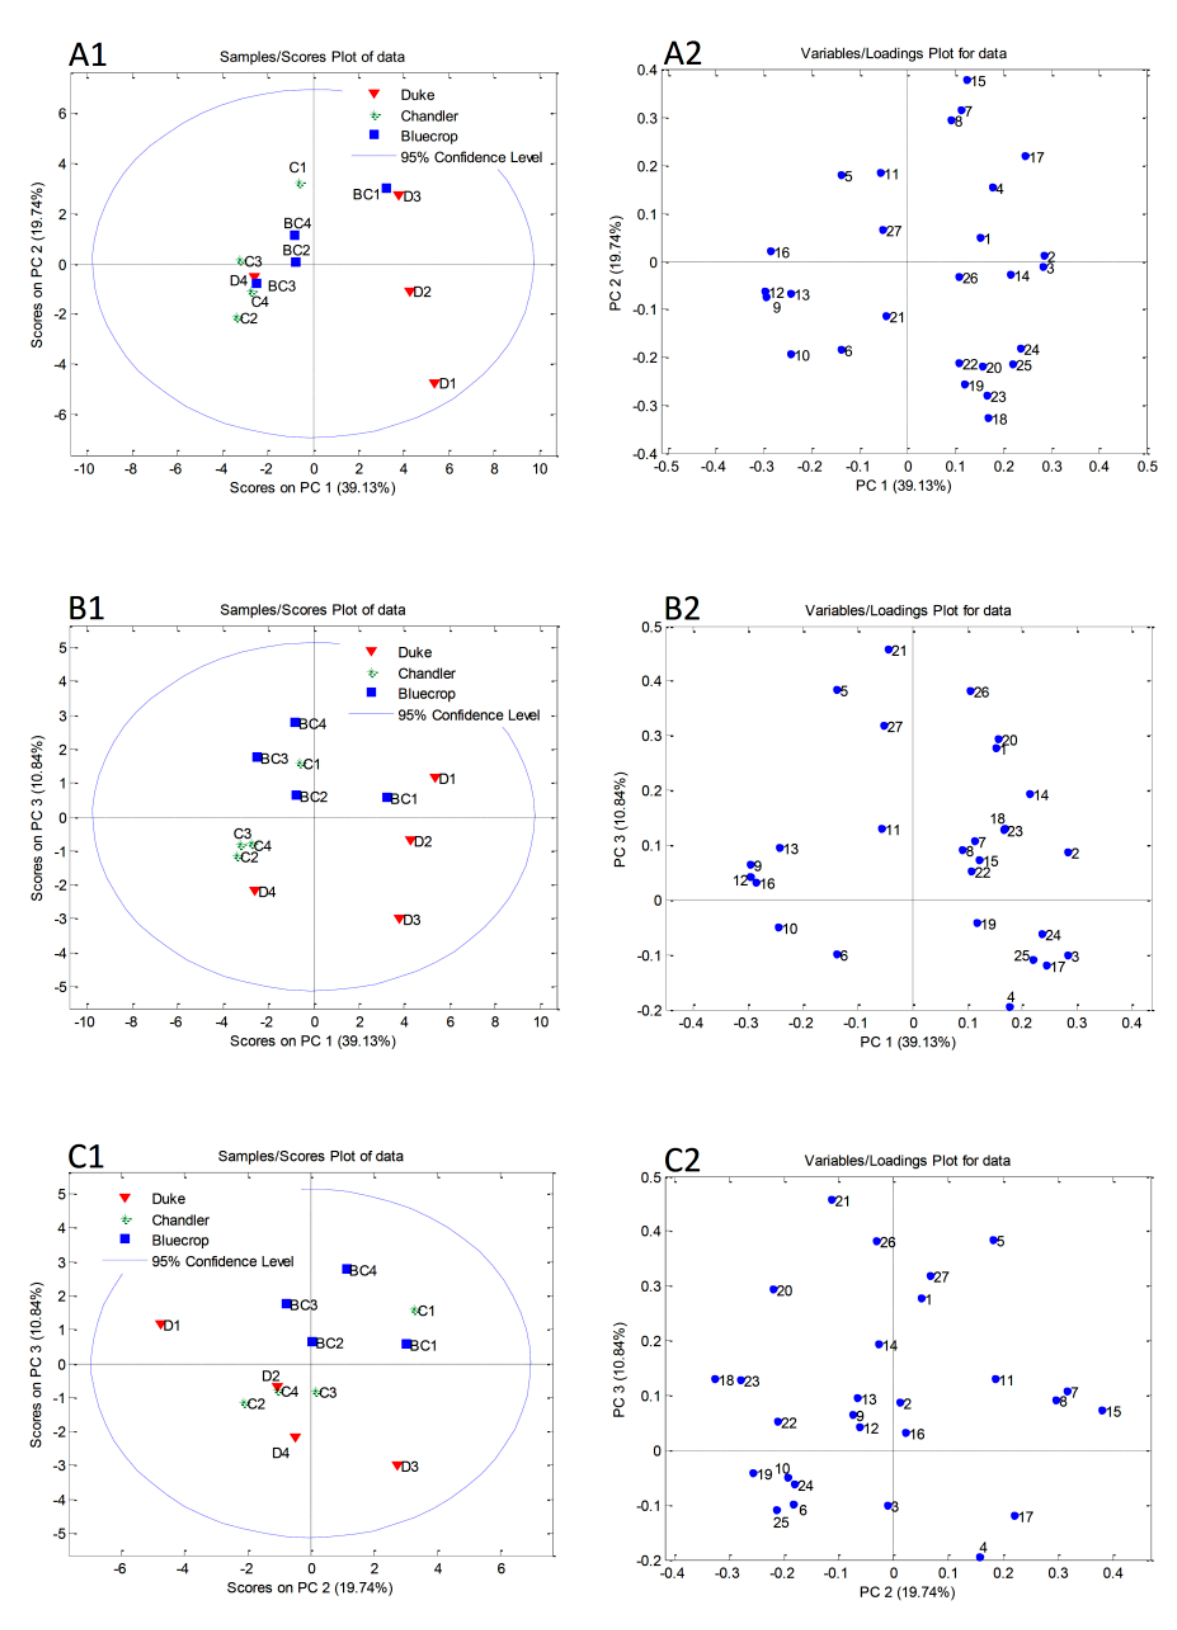
Figure 4. Principal component analysis (PCA) performed on chemical parameters obtained for blueberry samples: Score plots of the first three principal components ( A1 – C1 ) and loading plots ( A2 – C2 ). The number of the loading plots corresponds to the chemical properties given in Table S1.